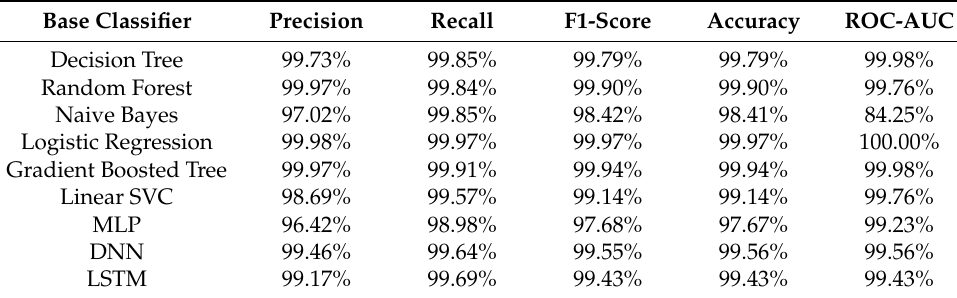
Table 5. Precision, Recall, F1-Score, Accuracy, and ROC-AUC